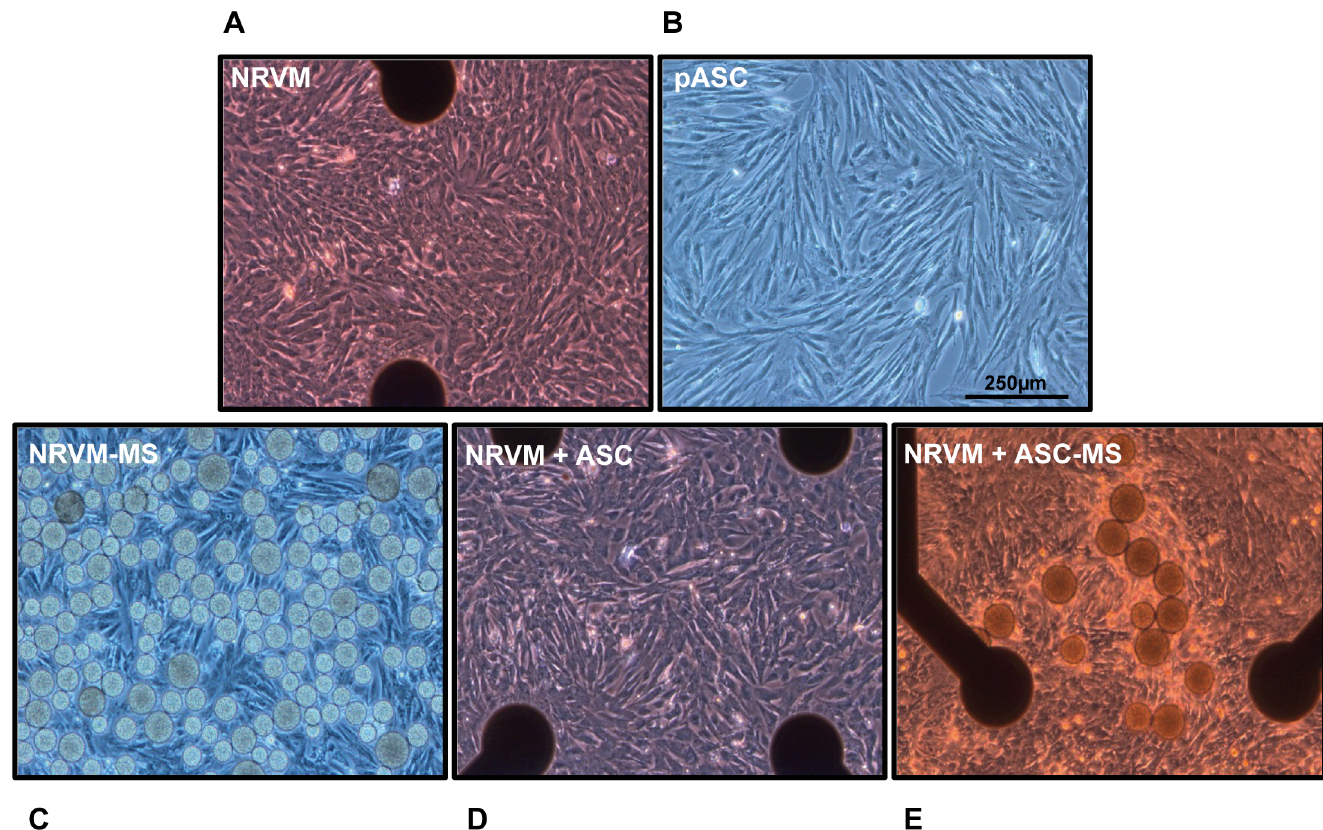
Fig 3. Light microscope image of the two main cell types used and the different cultures. A: Monolayersof NRVM culturedon multi-electrode arrays, B: Porcine ASC in culture, C: Monolayersof NRVM culturedtogether with microspheres, D: Co-cultures of NRVM and porcine ASC on a multi- electrode array and E: Co-culturesof NRVM and porcine ASC loadedon microspheres. Original magnification 10x. Black dots represent electrode terminals in the multi-electrode arrays. Abbreviations; ASC: adiposetissue-derived stromal cells, MS: microspheres and NRVM: neonatalrat ventricular